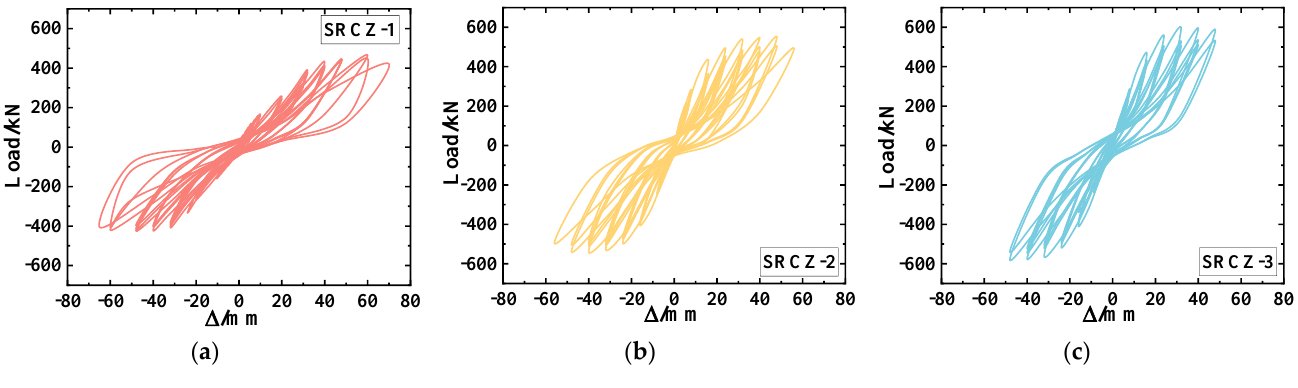
Figure 7. The Hysteresis Loops. ( a ) SRCZ-1. ( b ) SRCZ-2. ( c ) SRCZ-3.